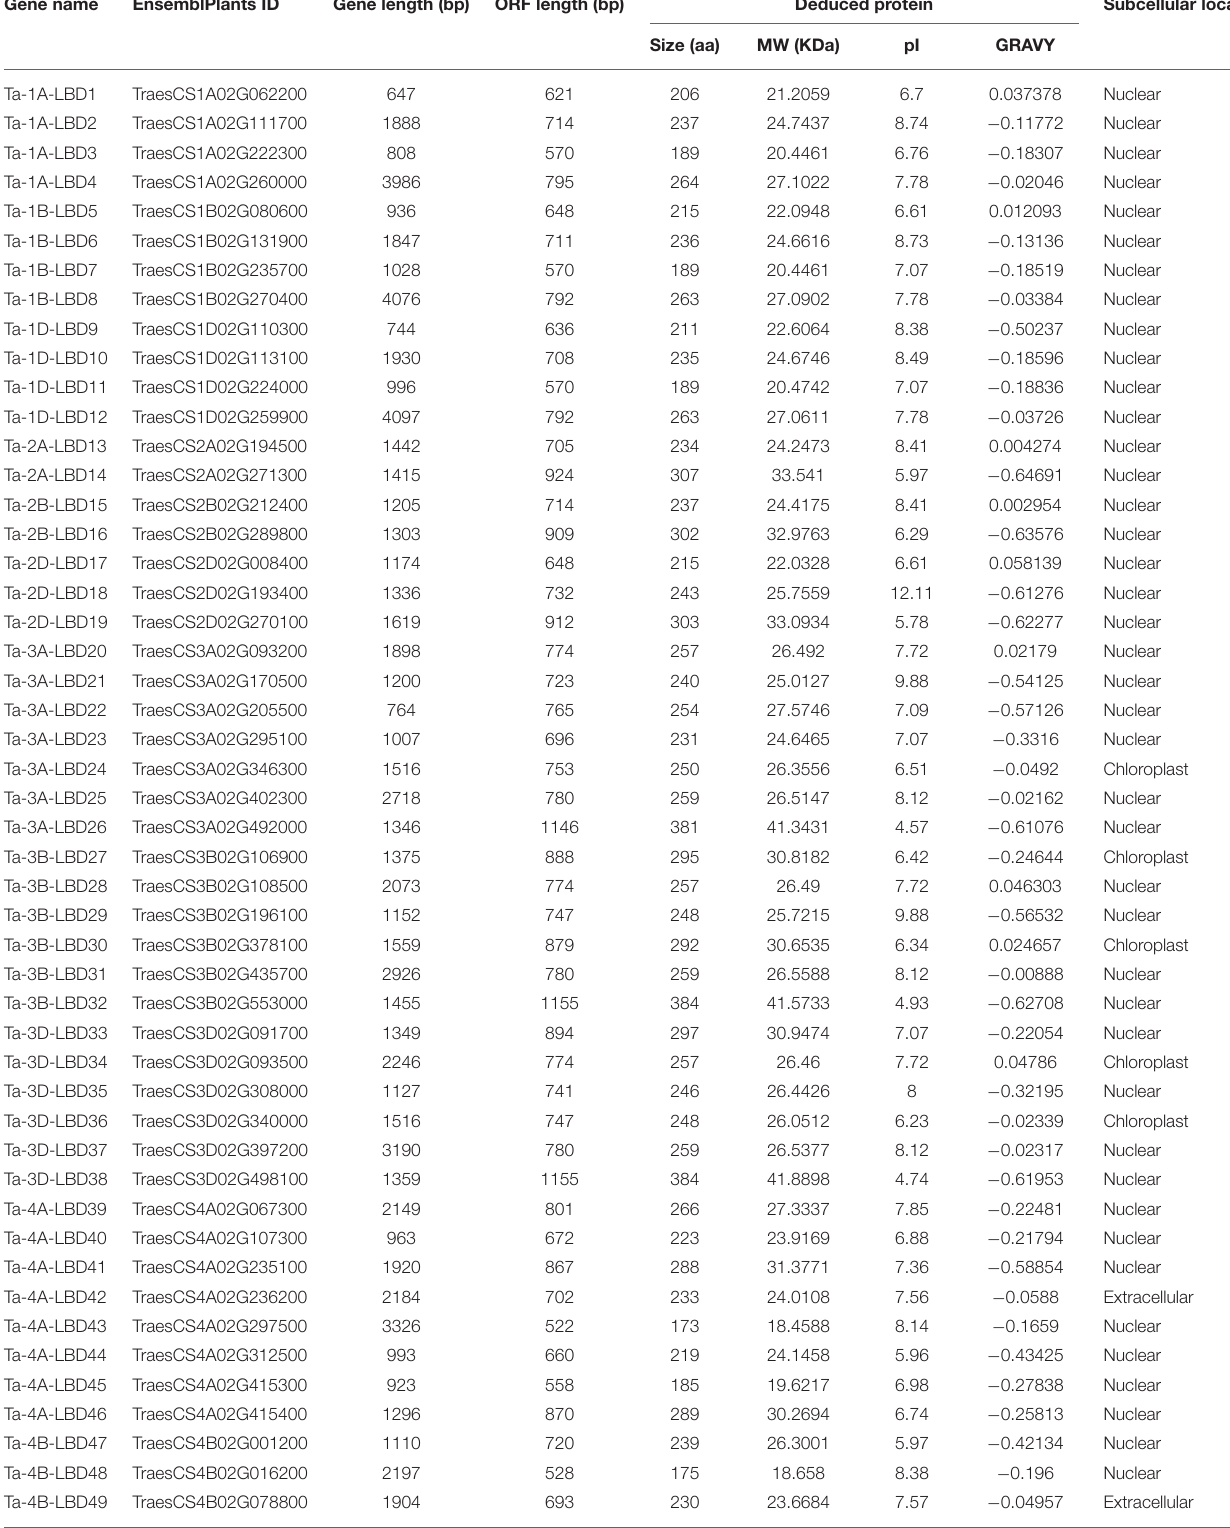
TABLE 2 | Basic information of the LBD genes identified in